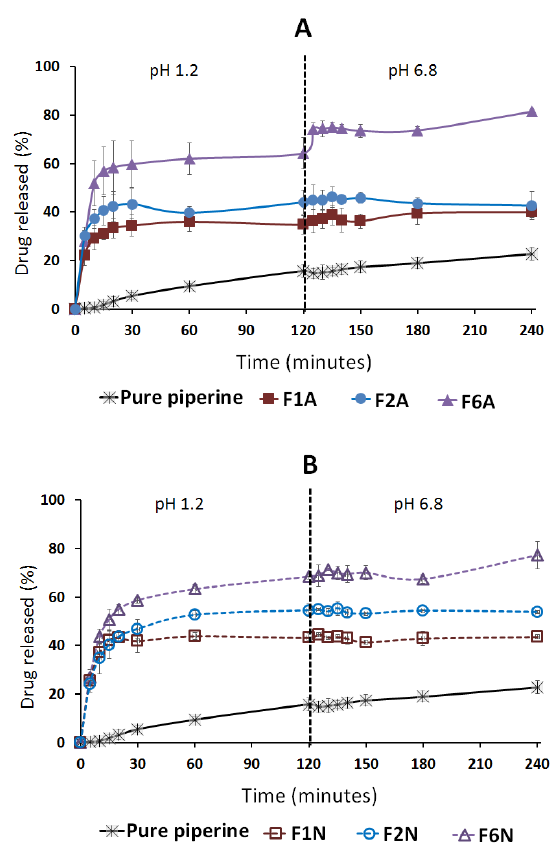
Figure 11. Influence of formulation type and pH on piperine release from solid SNEDDS. ( A ) Denotes A-300 and ( B ) NUS solidified SNEDDS. The dashed line indicates the time point at which the dissolution media was shifted from pH 1.2 to pH 6.8. Data are expressed as mean ± SD. Details of the formulation compositions are presented in Table 6.